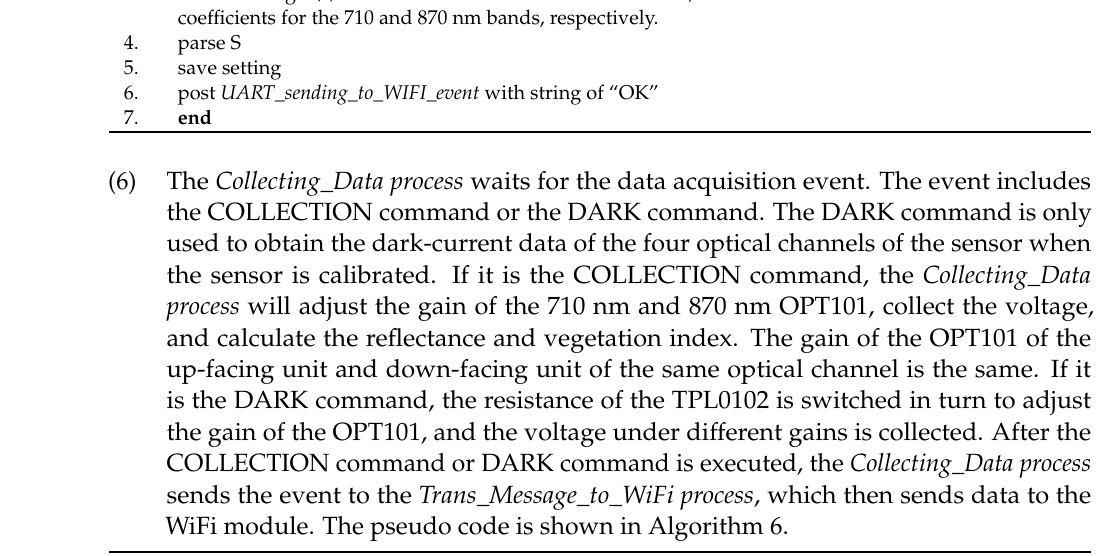
Algorithm 6: The pseudo code of the Calibration process